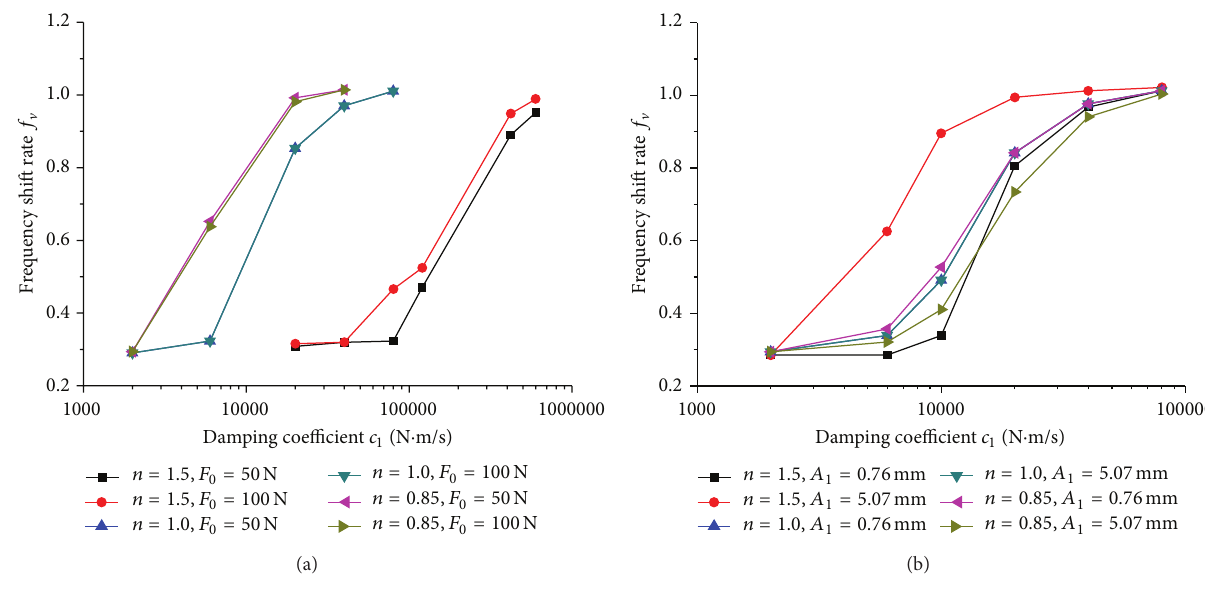
Figure 16: Frequency shift rates of GNM. (a) FE cases; (b) FDE cases.